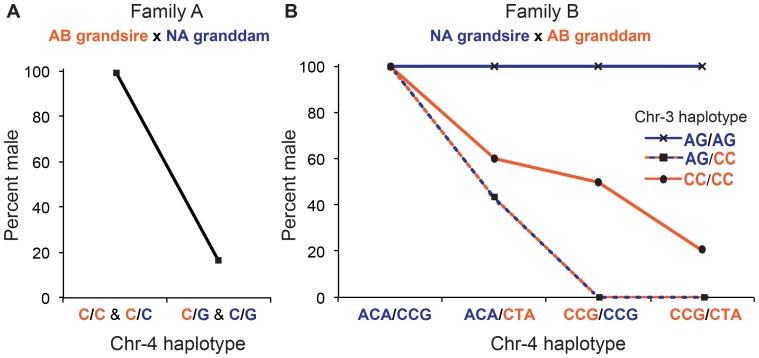
Relationships between sex phenotype and haplotype on chr-3 and -4.(A) In Family A, all individuals homozygous for the C allele at Marker ID29464 chr-4∶61,176,889 bp were male and 84% of individuals heterozygous at this marker were female. (B) In Family B, loci on chr-3 and -4 appear to interact to influence sex (marker ID32525 chr-4∶61,422,807bp; marker ID29552 chr-3∶20,676,406bp). Individuals homozygous for grandsire-derived alleles at the chr-4 locus developed as males independent of their chr-3 genotype and animals homozygous for granddam-derived alleles were all or nearly all female without regard to their chr-3 genotype. On the other hand, individuals that were homozygous for the grandsire-derived alleles at the chr-3 locus were male independent of their genotype at the chr-4 locus.